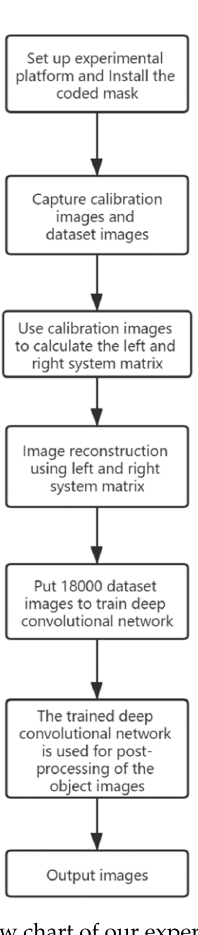
Figure 5. The flow chart of our experimental process.